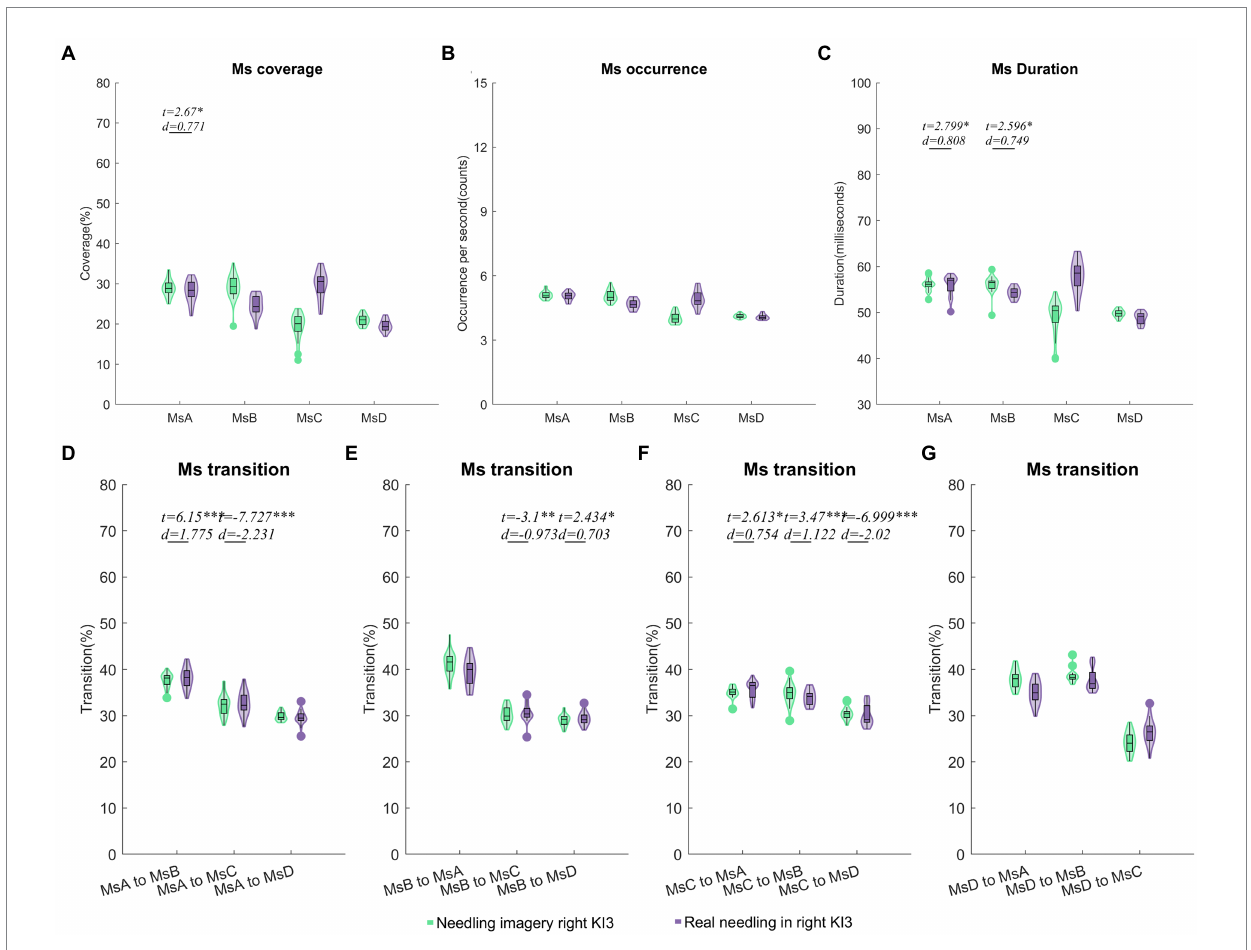
FIGURE 4 Comparisons of temporal dynamics between needling imagery and real needling in right KI3. Comparison results of coverage (A) , occurrence per second (B) , duration (C) and Markov chain transition probabilities (D–G) of the four microstates. In these comparisons, a two-sample t test after a generalized linear model (GLM) with age, sex and resting state microstate parameters was regressed out. Two sample t test with FDR correction * p < 0.05, ** p < 0.01, *** p < 0.001; d values indicate effect size (Cohen’s d ). Ms, microstate; RA, real